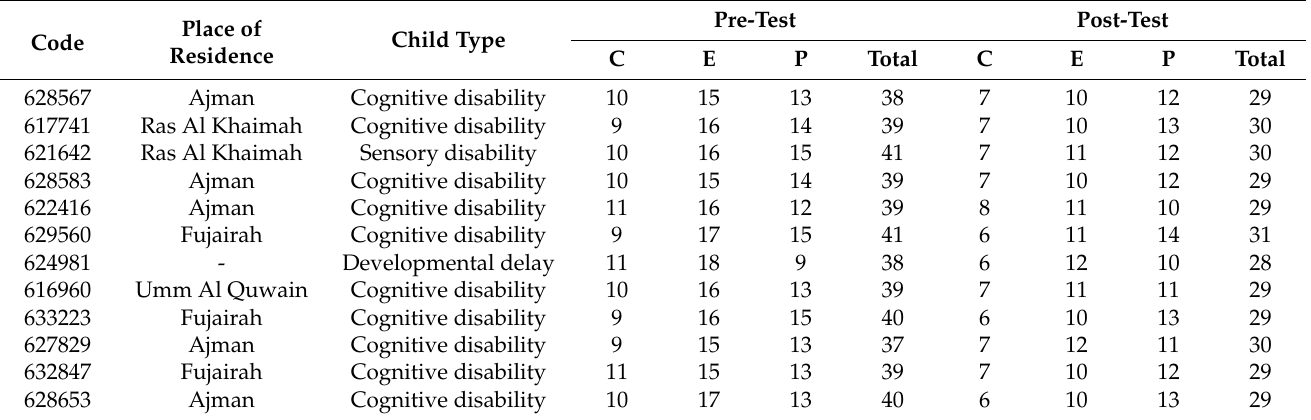
Table 2. Summary of pre- and post-test stress